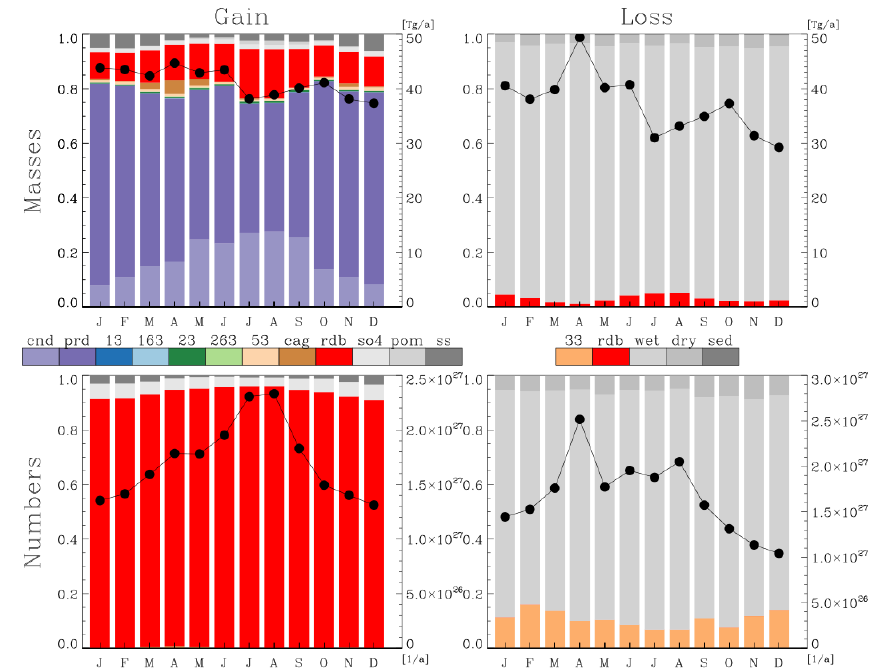
Figure 18. Seasonal cycle of regional tendencies of the hydrophilic accumulation mode over East Asia (see Fig. 1). The colored bars show fractional tendencies (left axis) for the processes defined in Table 2. The solid line (right axis) shows the total tendency.